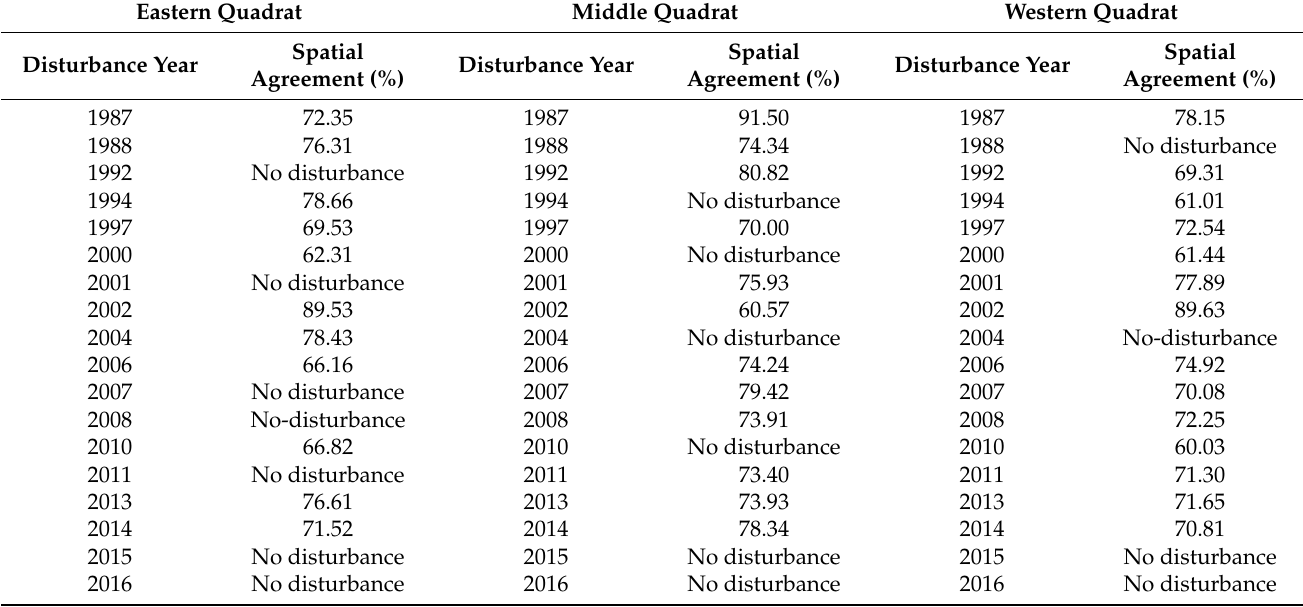
Table 3. The spatial agreements between the three randomly created validation plots (9 m 2 ) and the forest disturbance map obtained from VCT. Eastern Quadrat Middle Quadrat Western